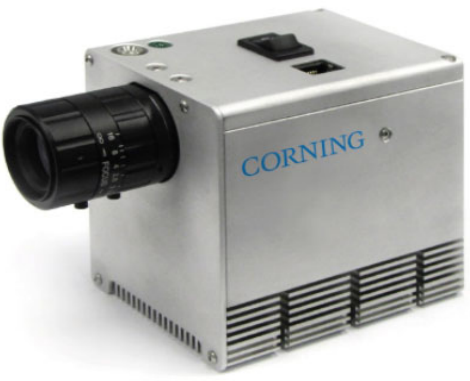
Figure 4. Micro HSI 410Shark model (Corning, NY, USA).